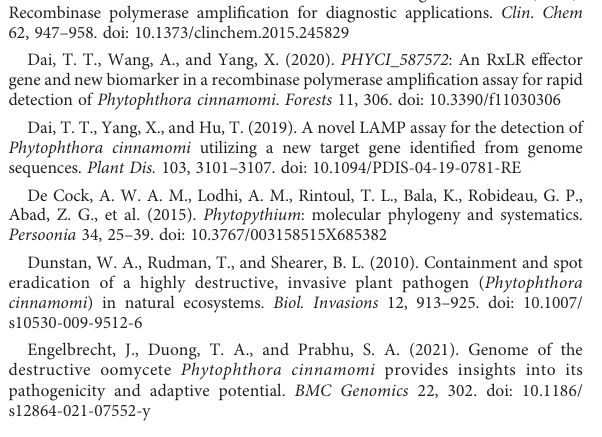
SUPPLEMENTARY FIGURE 6 Evaluation of speci fi city of the PCR assay based on the target Pcinn17552 . Conventional PCR products ampli fi ed with primers Pcinn17552 -F and Pcinn17552 -R are detected by 2% agarose gel electrophoresis. PCR amplicons were also detected in samples using gDNA from other Phytophthora species, indicating a lack of speci fi city in detection of P. cinnamomi DNA. Pcinn17552 was found to be non-speci fi c for detecting P. cinnamomi . Marker DL1000 (Takara Shuzo, Shiga, Japan). Negative control (NTC). SUPPLEMENTARY FIGURE 7 Maximum parsimony phylogeny for Pcinn13739 . The phylogenetic relationship of Pcinn13739 derived from maximum-likelihood (ML) analysis. BLAST searches revealed Pcinn13739 in different branches of a phylogenetic tree with nine closely related genes (https://fungidb.org/ fungidb/app/search/transcript/Uni fi edBlast). SUPPLEMENTARY TABLE 1 Publicly available genome sequences of 34 Phytophthora species, eight Pythium species, fi ve Fusarium species, and Phytopythium vexans.